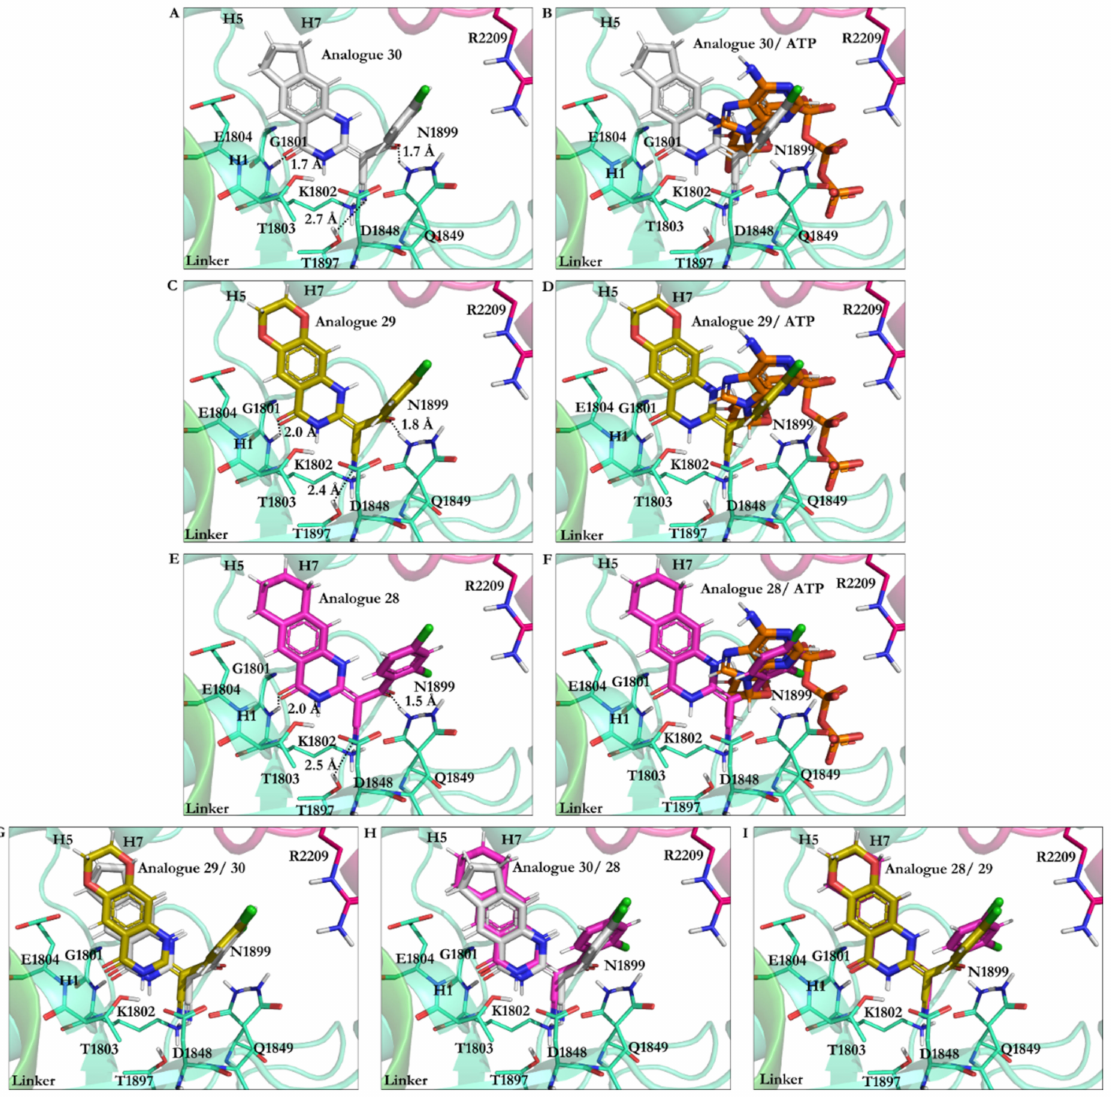
Figure 9. Analogues of ciliobrevin at the AAA1 binding site of dynein 1. ( A ) Analogue 30. ( B ) Analogue 30 superimposed on ATP. ( C ) Analogue 29. ( D ) Analogue 29 superimposed on ATP. ( E ) Analogue 28. ( F ) Analogue 28 superimposed on ATP. Superimposition of ( G ) analogues 29 and 30, ( H ) analogues 30 and 28, and ( I ) analogues 28 and